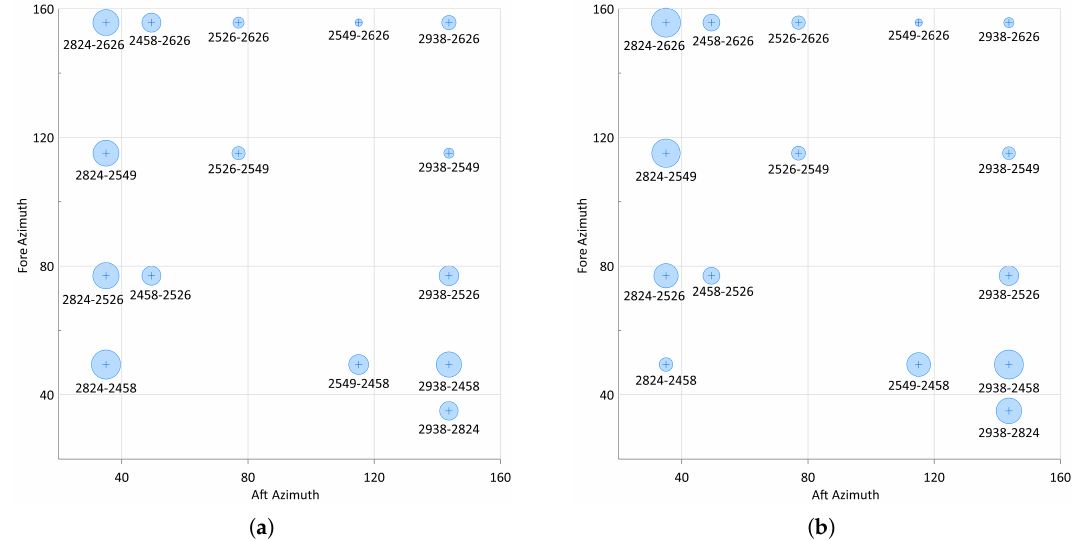
Figure 10. Medians ( a ) and IQRs ( b ) of the M3C2 distance in the Centre area depending on the azimuths of the fore and aft images of stereo-pairs. The size of the bubbles is proportional to median and IQR value,